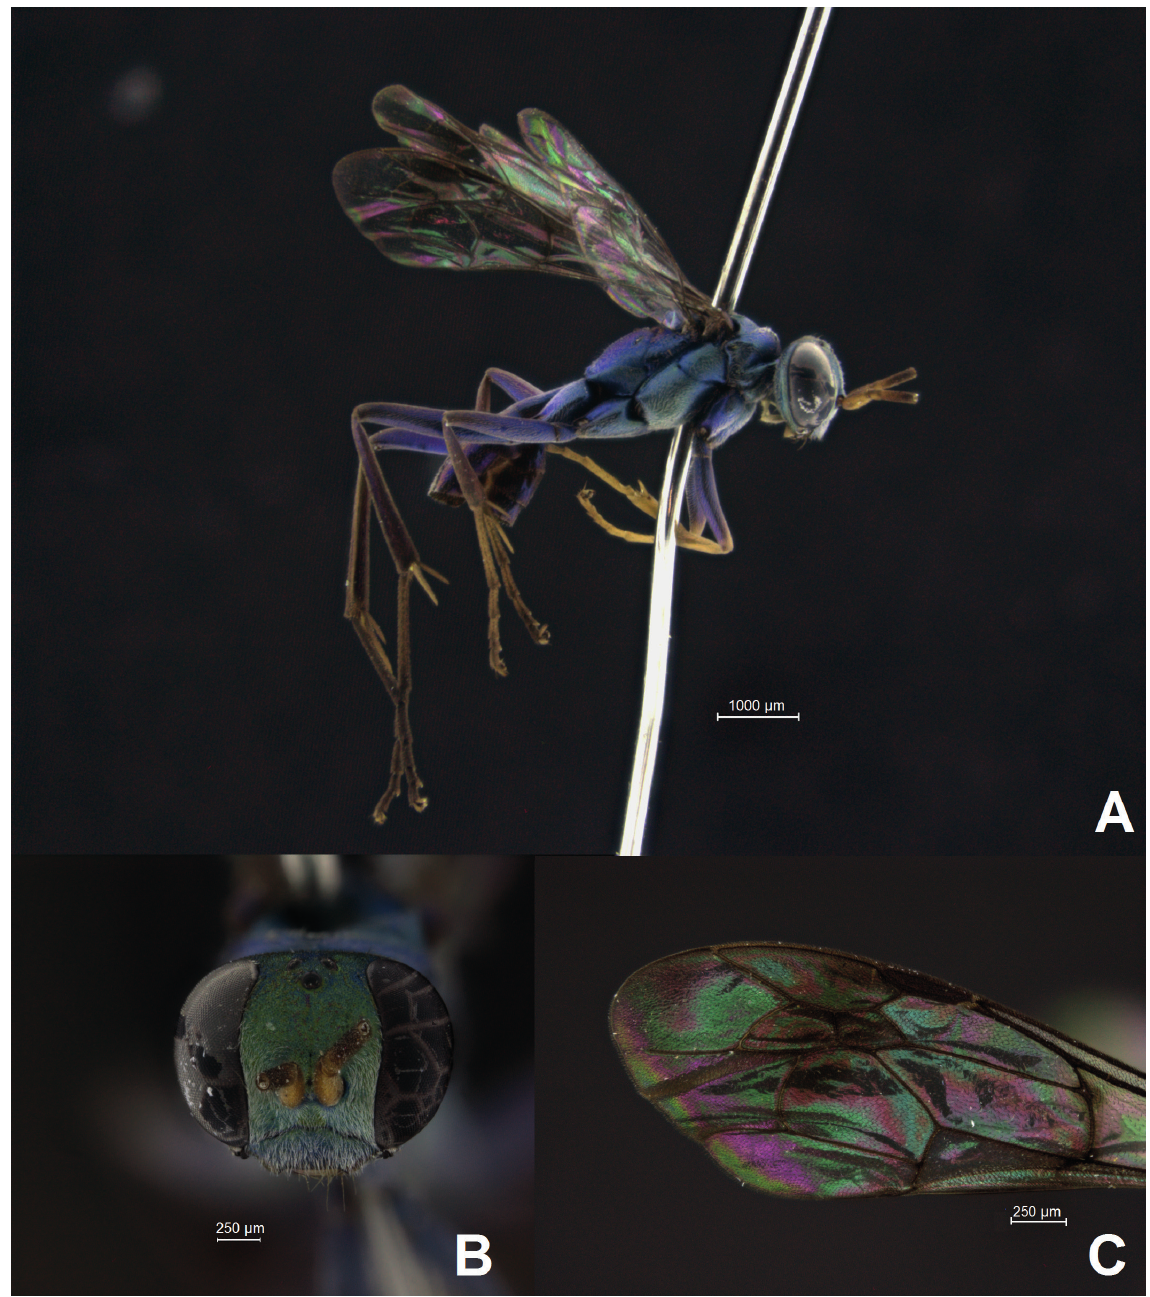
Fig. 2. Ageniella caerulea sp. nov., ♂, allotype (INPA). A . Profile. B . Head, frontal view. C . Fore